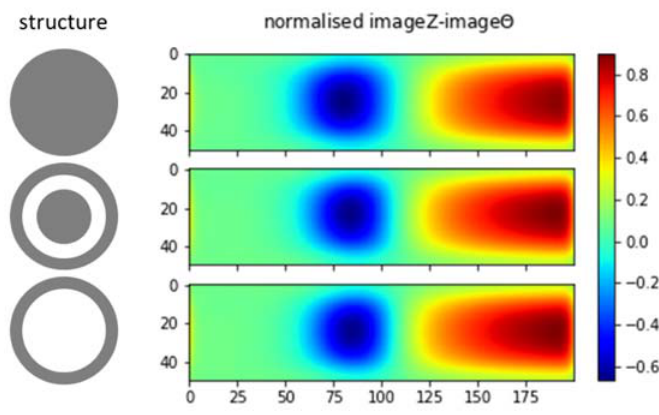
Figure 22. Combination of normalised Z- θ spectrum metallic structures: hollow, hollow-with-inclusion, solid.